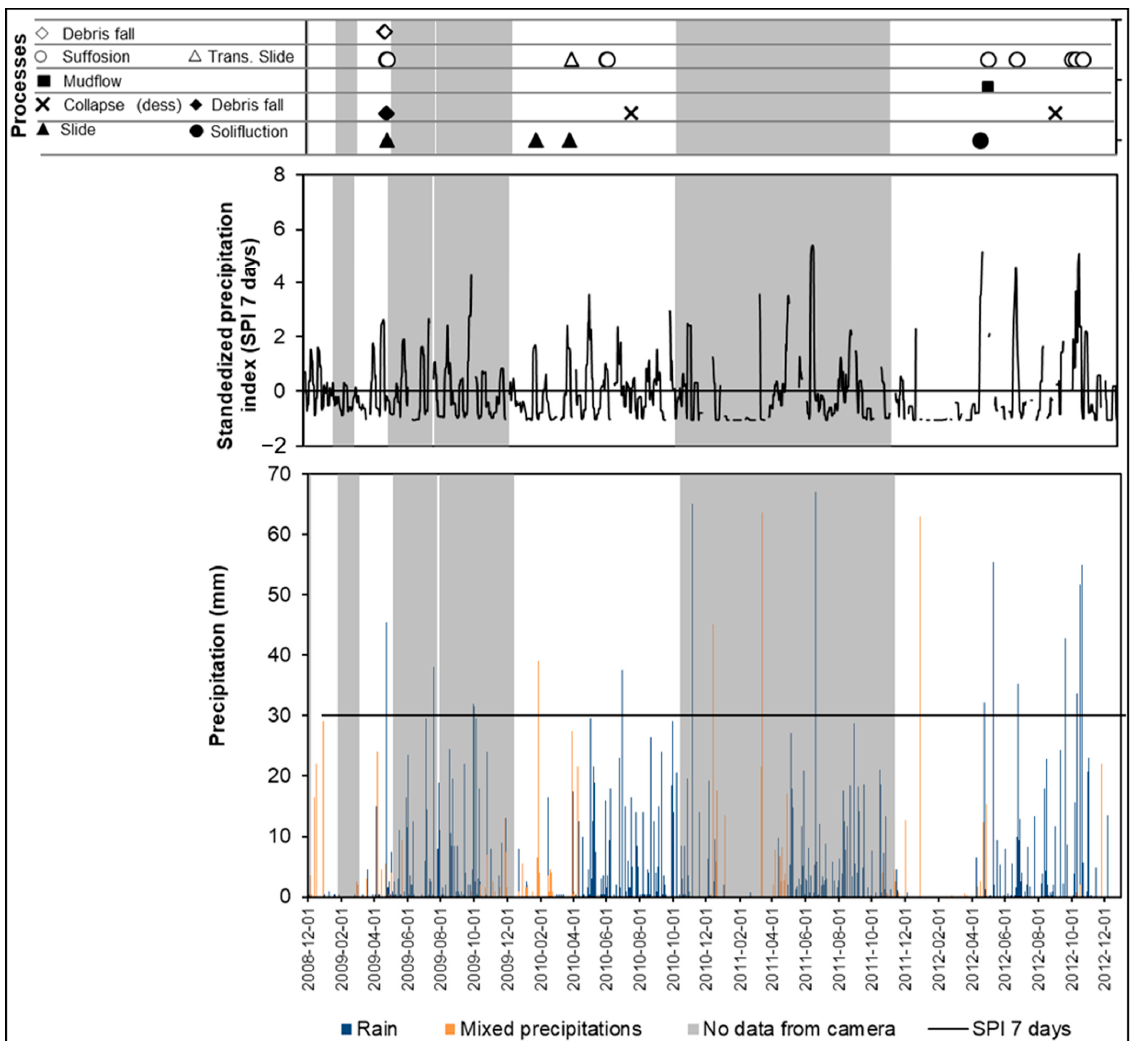
Figure 19. Chronology of the different hydrogeological erosion events in relation to the processes, precipitation events, and the standardized precipitation index (SPI) of seven days.